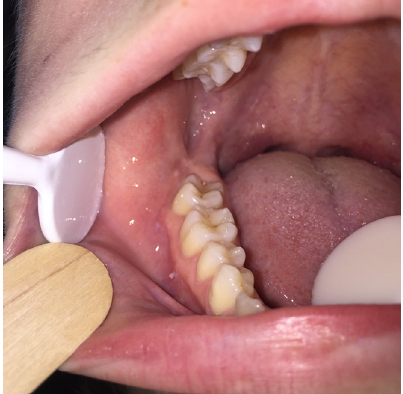
Fig. 1. Lymphatic malformation of the right retromolar trigone. A translucent vesicular lesion next to the distovestibular cuspid of 47 is noticeable. The fact that it appears to be healing indicates that no further investigation is